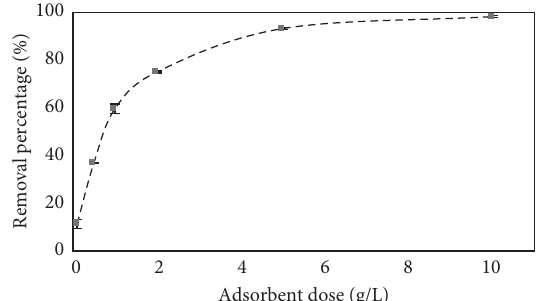
Figure 8: Effect of adsorbent dose on Cr(VI) ions removal from aqueous solution using WM adsorbent at T � 298 ( K ), pH � 2, time � 120min, and [Cr(VI)] � 50mg/L.